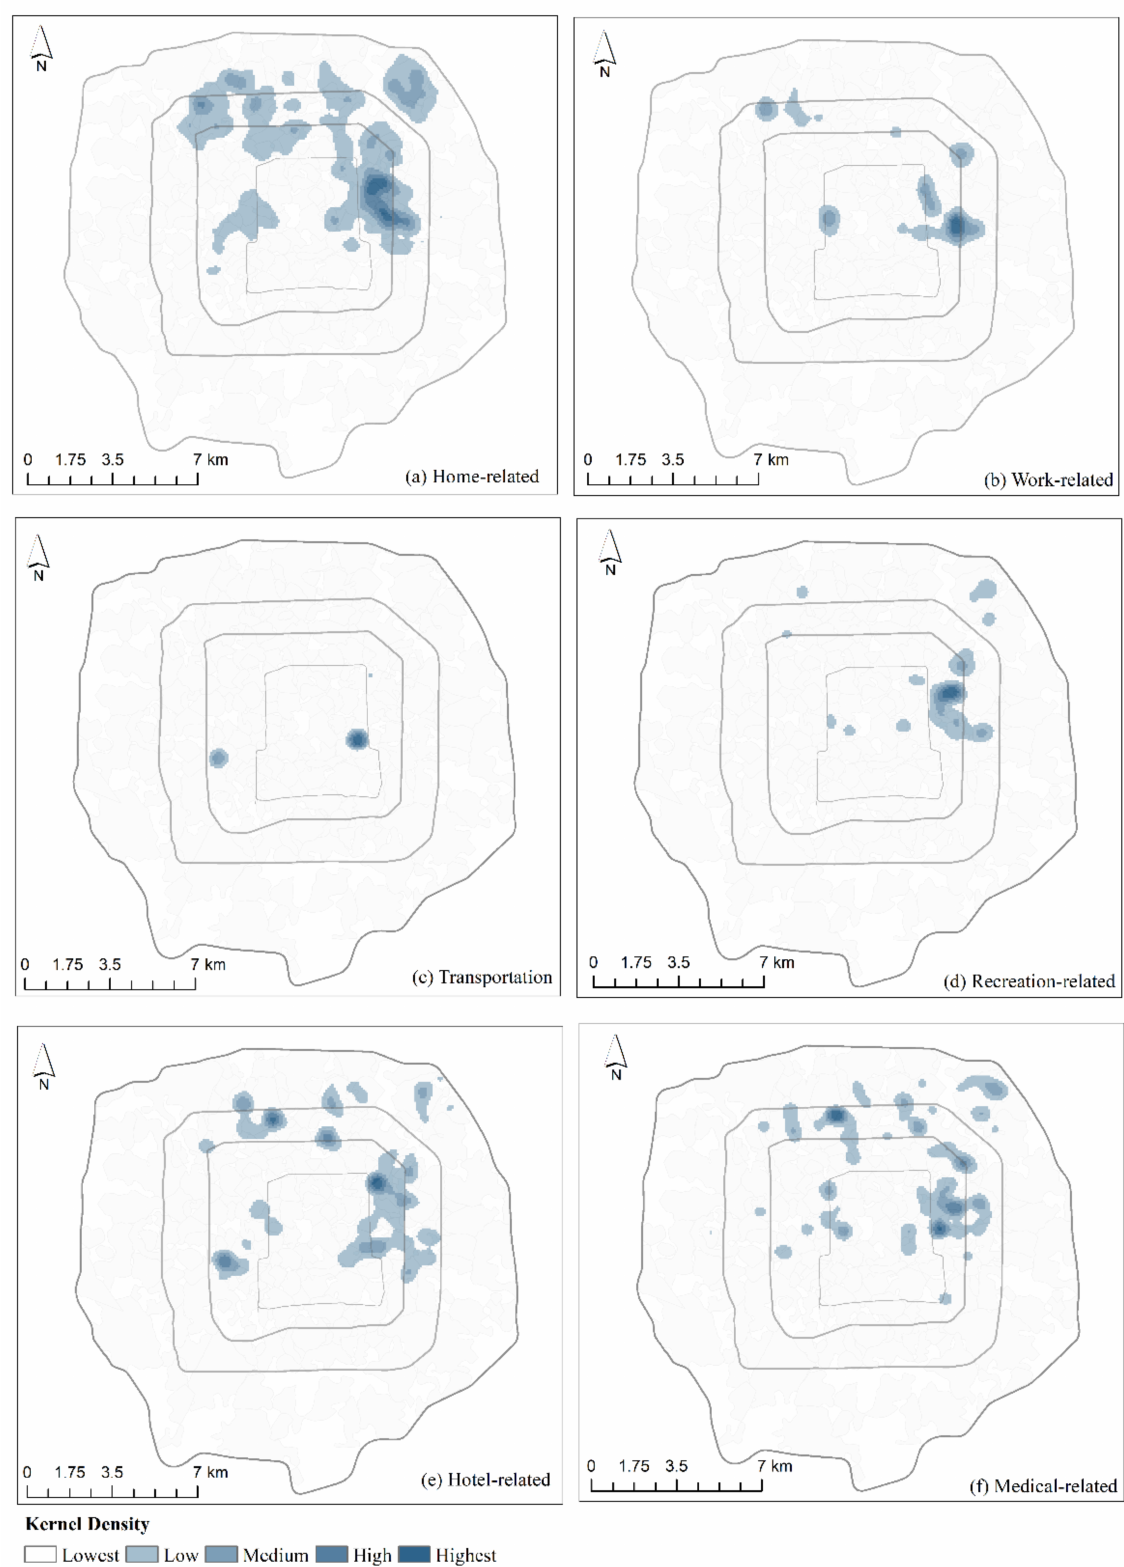
Figure 7. The spatial distribution of different travel activities